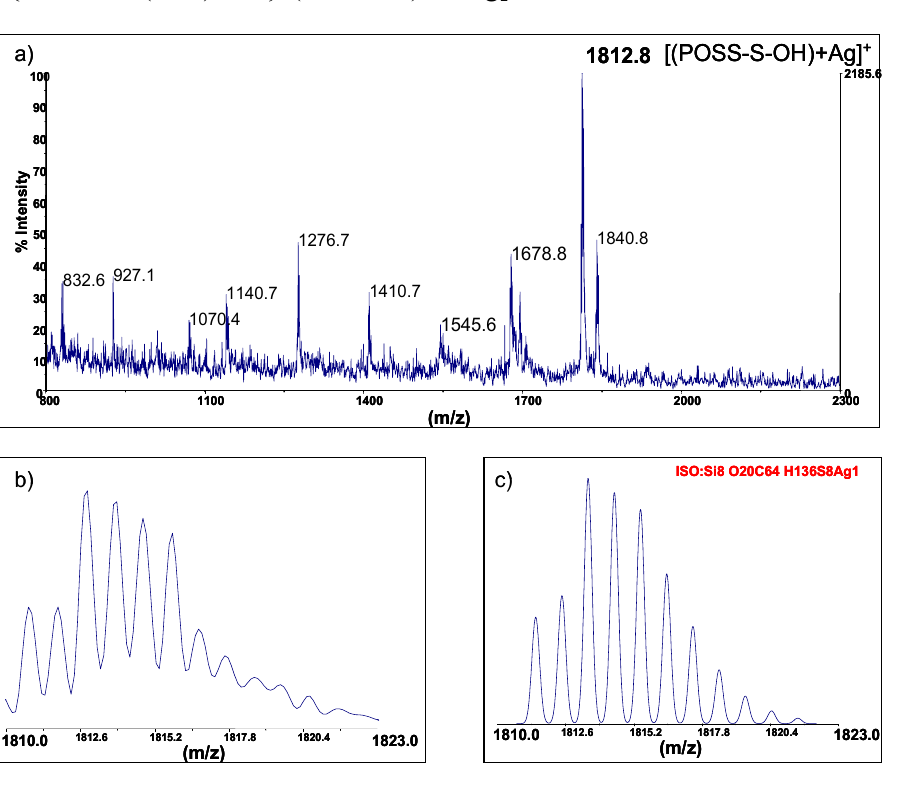
Figure 3. MALDI-TOF spectra (linear mode, AgTFA added) of the (POSS-S-OH)(1), C 64 H 136 O 20 S 8 Si 8 , 1706.44. ( a ) containing 99.45% of reactive –(CH 2 ) 2 S(CH 2 ) 6 OH groups; ( b ) expansion of the 1810–1823 m / z range; ( c ) simulated